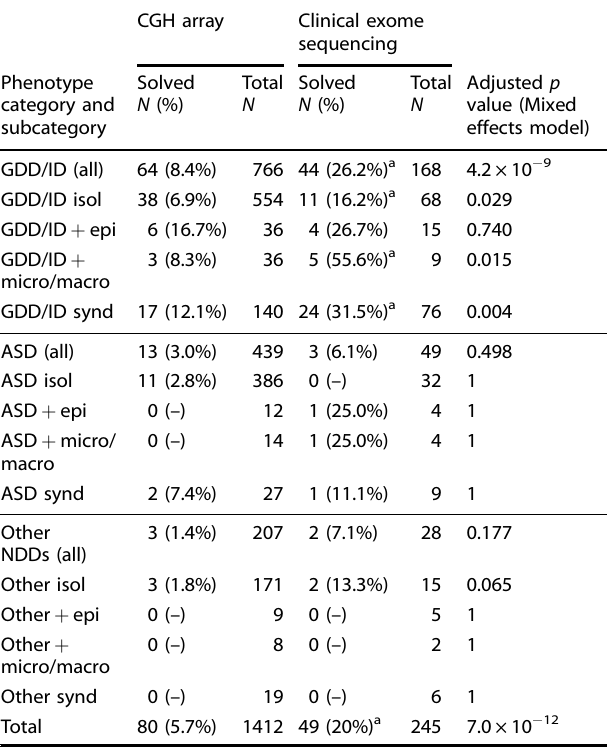
Table 5. Diagnostic yield for aCGH and clinical exome sequencing and statistical comparison between both